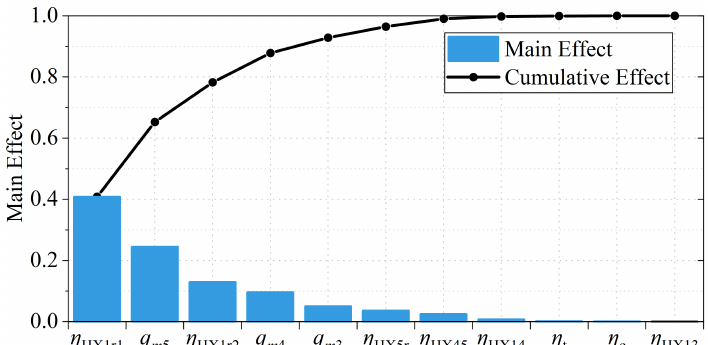
Figure 7. Analysis of variance of main influencing factors on fuel